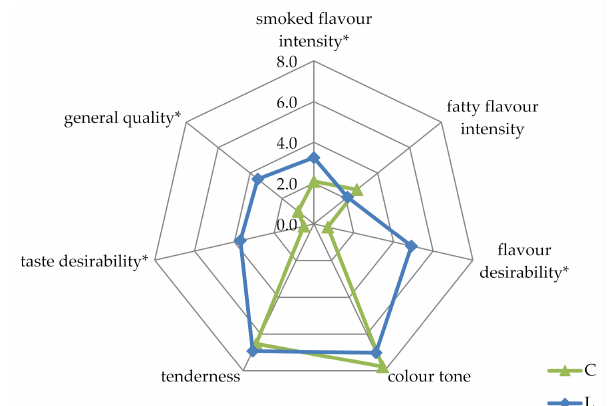
Figure 2. Sensory evaluation of MSPM sausages after 3 weeks of refrigerated storage. C—control treatment with MSPM without a bacteria strain, L—treatment with MSPM and the bacteria L. plantarum SCH1 (10 7 cfu/g); * Mean values of this attribute are significantly different ( p <